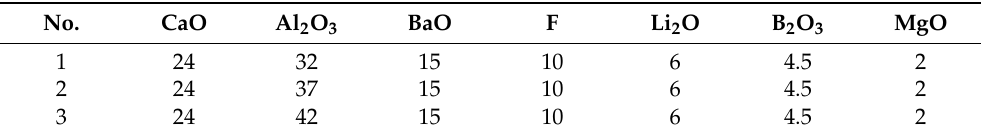
Table 1. Composition of mold fluxes